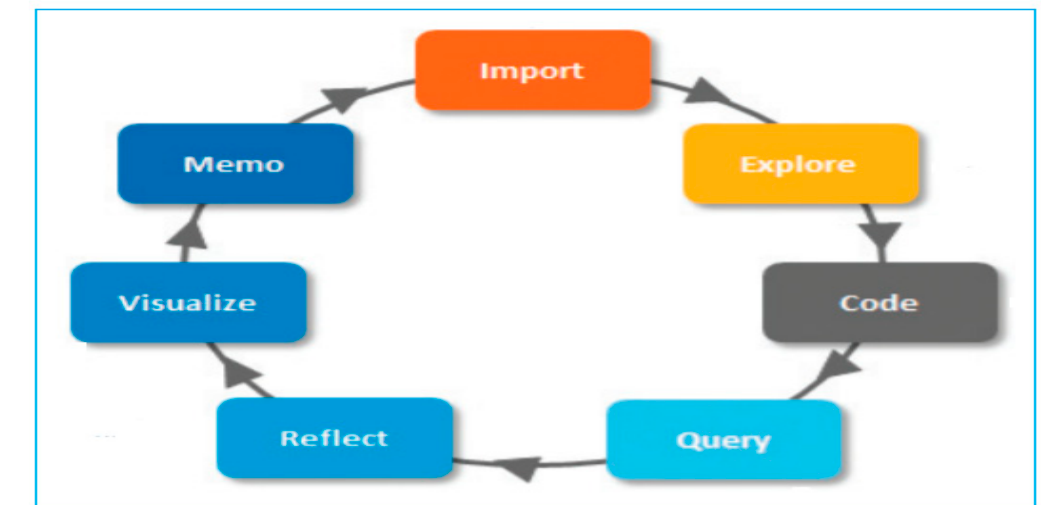
Figure 2. The qualitative analysis path to explore the themes.